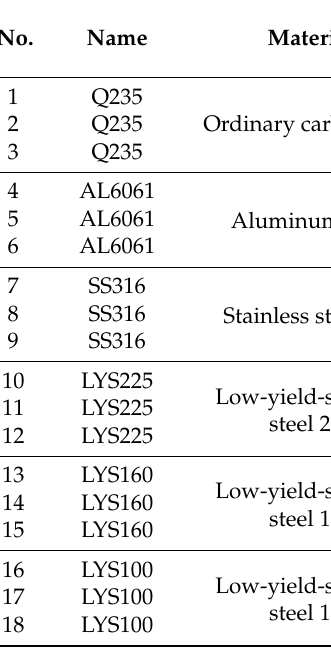
Table 1. Specifications of test specimens.